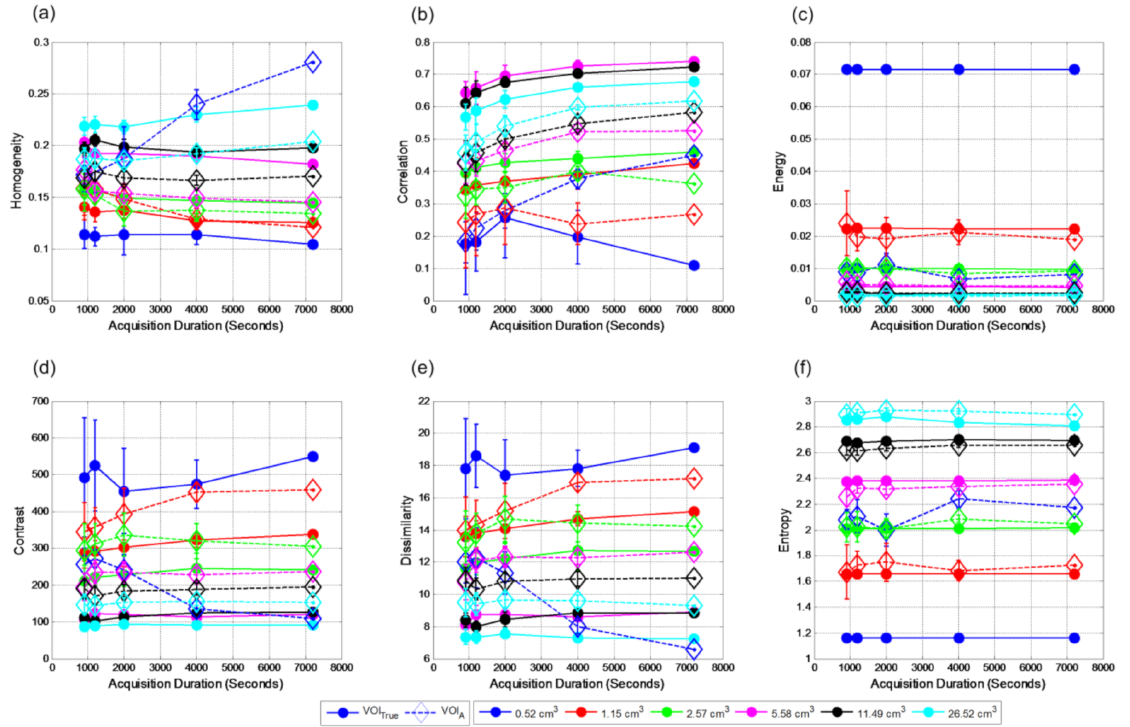
Figure 9. Six textural features vs. acquisition durations for two different segmented volumes (VOI true and VOI A ) for contrast 2:1 and quantization level 64. ( a ) Homogeneity, ( b ) contrast, ( c ) energy, ( d ) contrast, ( e ) dissimilarity and ( f )